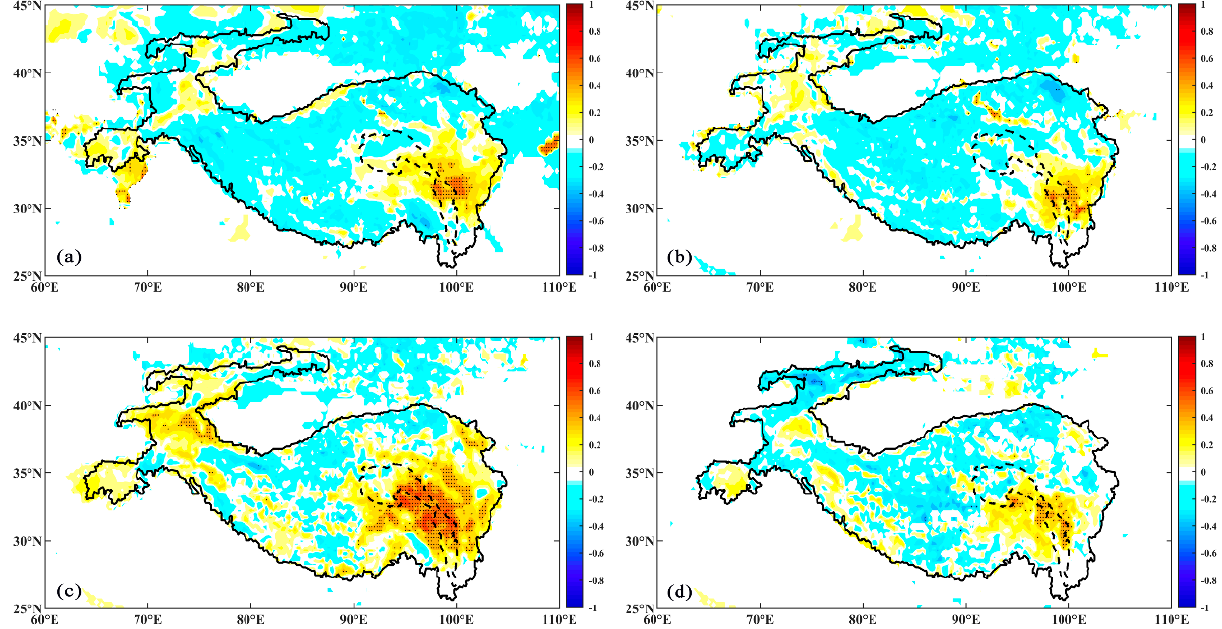
Figure 6. Spatial correlation distribution of flow at Shigu Station and plateau snow during snowmelt season (( a ) SNL and April runoff; ( b ) SNS and April runoff; ( c ) SNL and May runoff; ( d ) SNS and May runoff. Shading area means confidence level is above 0.01).